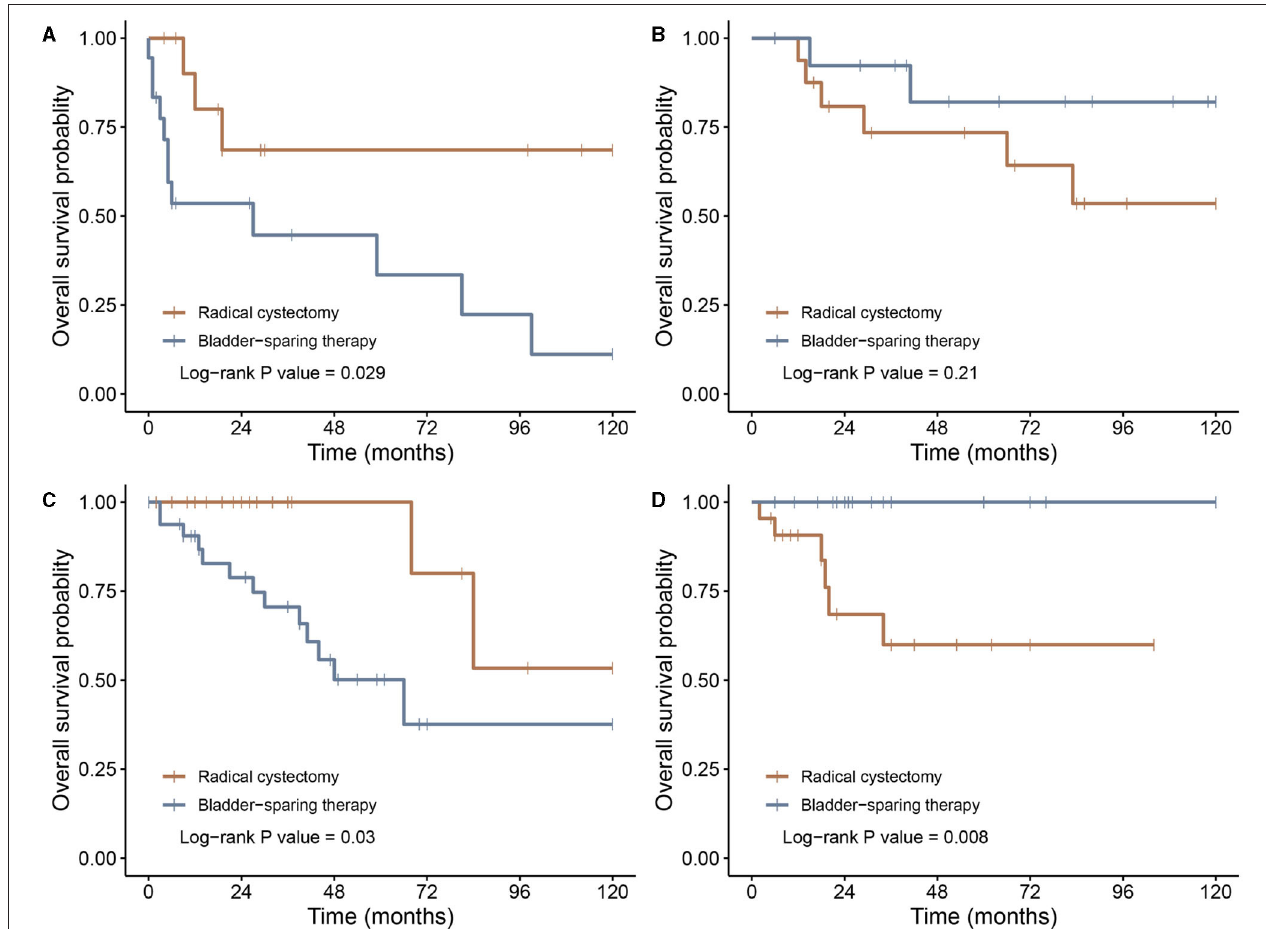
FIGURE 3 | Kaplan–Meier survival curves of patients undergoing radical cystectomy or bladder-sparing therapy. (A) Patients older than 69 years in the SEER cohort; (B) patients younger than 69 years in the SEER cohort; (C) patients older than 69 years in the LR cohort; and (D) patients younger than 69 years in the LR cohort. LR, literature review; SEER, Surveillance, Epidemiology, and End